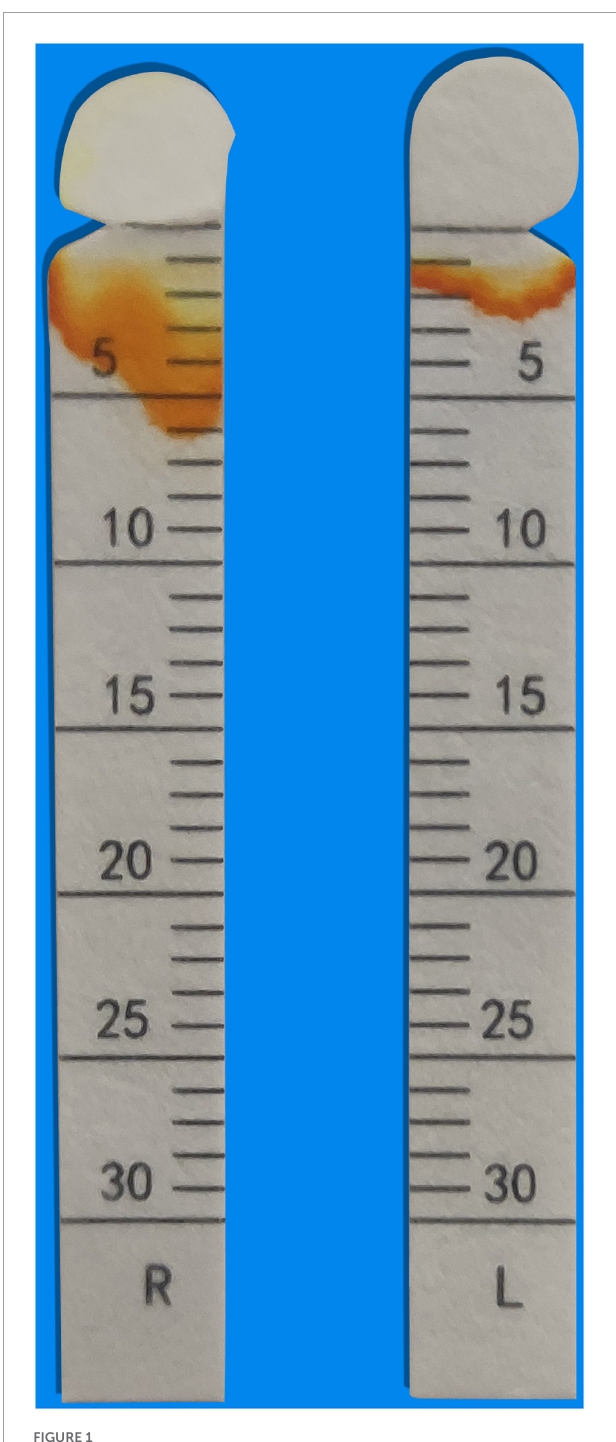
FIGURE1 Schirmer’s test. Schirmer test of < 5 mm per 5 min (left